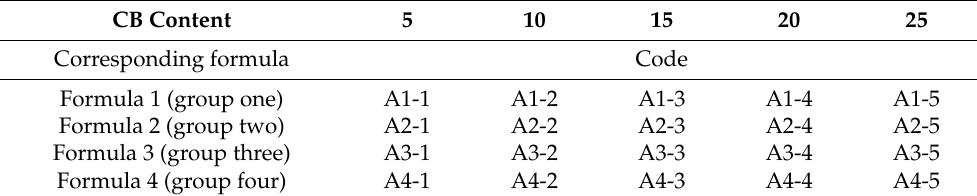
Table 6. The codes for the rubber compounds containing S.